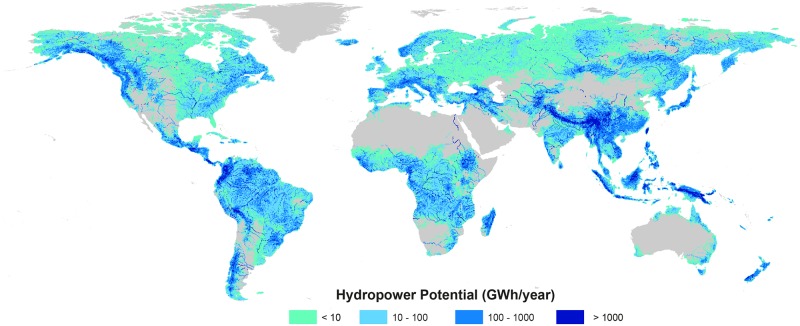
Global map of gross hydropower potential distribution.